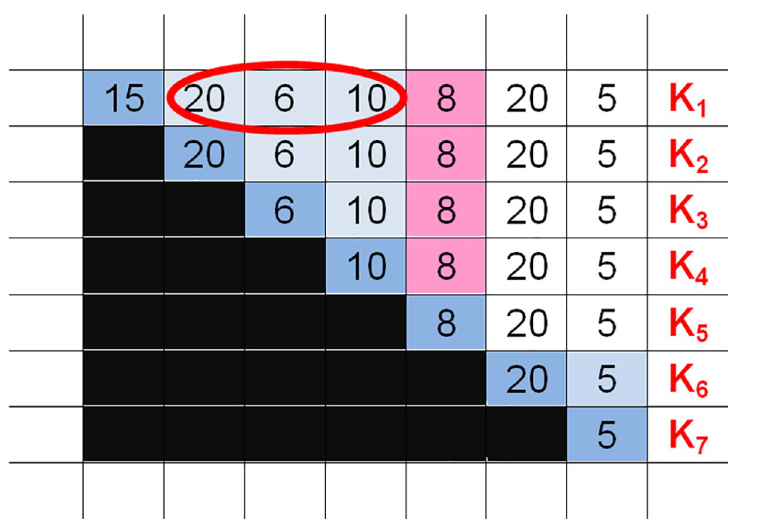
Fig 4. Elimination and graphical representation of irrational